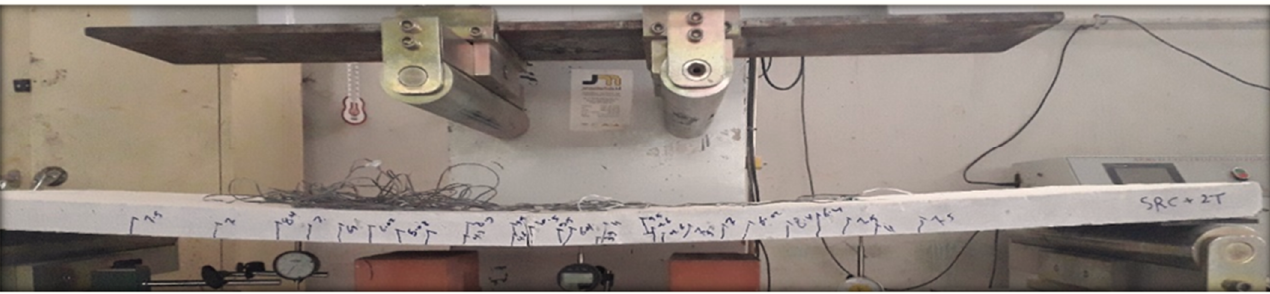
Figure 16. Failure of SRC + 2T tested slab.